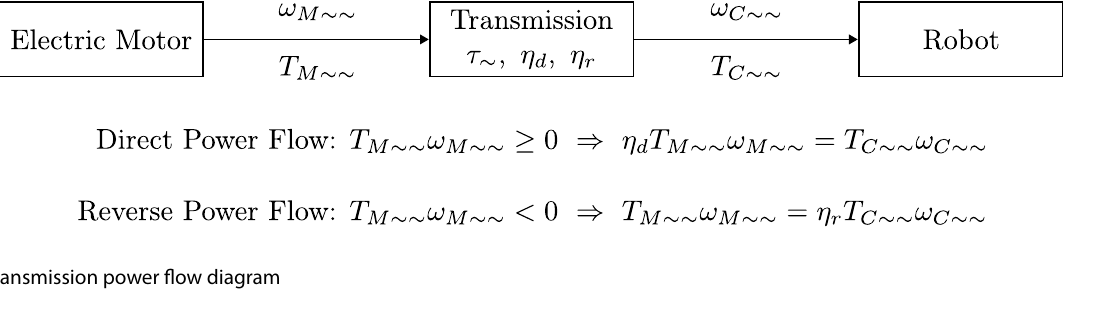
Fig. 14 Transmission power flow